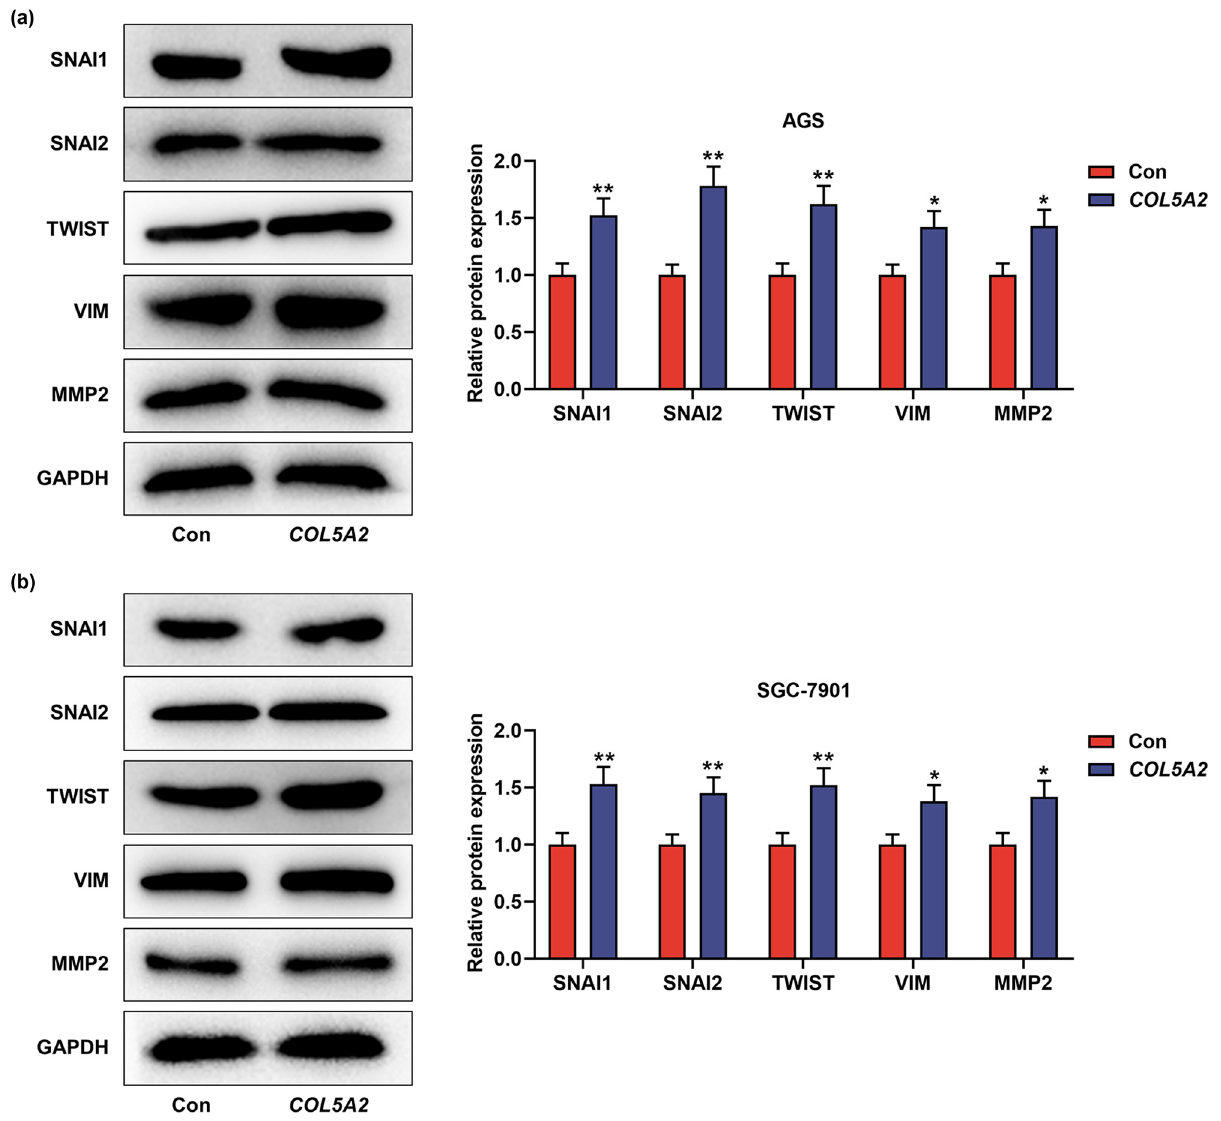
Figure 10: Overexpression of COL5A2 promoted biological behaviors of GC cells via inducing EMT - associated genes. ( a and b ) After AGS and SGC - 7901 cells were transfected with COL5A2 overexpression plasmid, the protein expressions of SNAI1, SNAI2, TWIST, VIM, and MMP2 in AGS ( a ) or SGC - 7901 cells ( b ) were analyzed by western blot assay. Data from three independent experiments were exhibited by mean ± SD. * P < 0.05, ** P < 0.01 vs Con